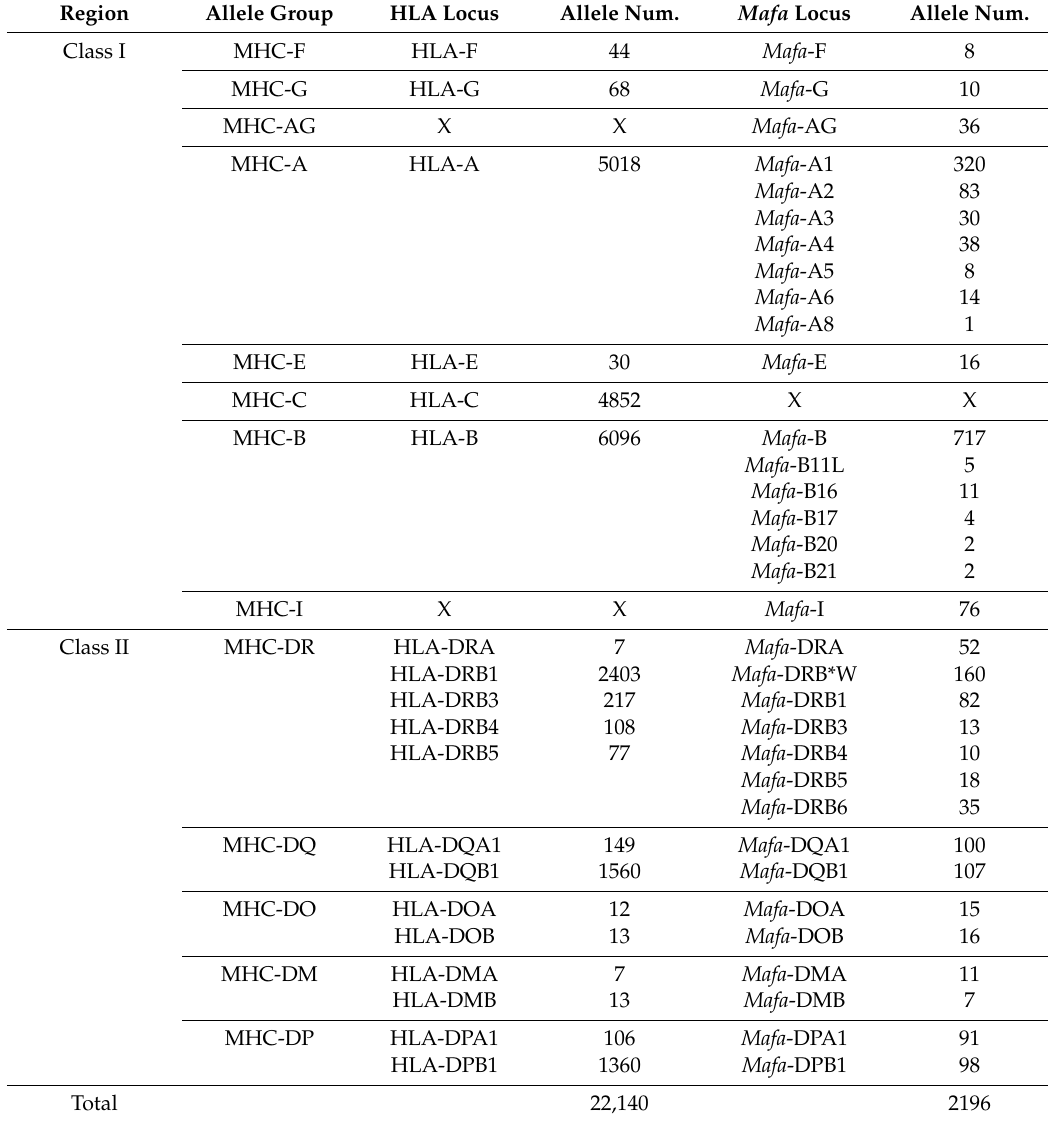
Table 1. Allele numbers of MHC genes in human and cynomolgus macaque. Region Allele Group HLA Locus Allele Num. Mafa Locus Allele